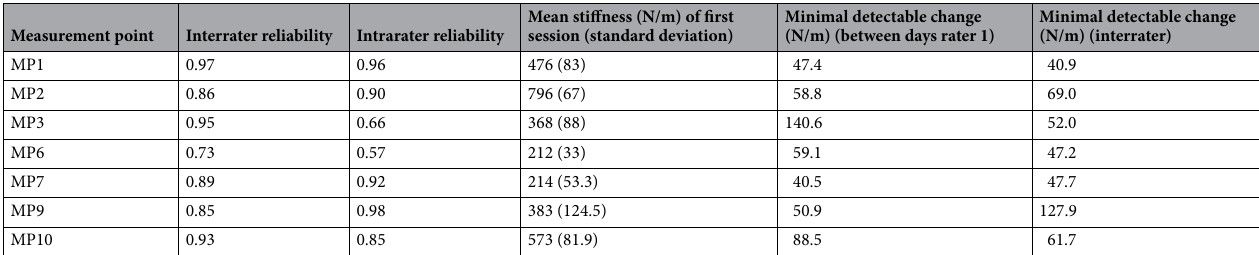
Table 1. MyotonPRO stiffness results for intrarater (between days) and interrater reliability, mean stiffness of first session and minimal detectable change (within and between raters). MP1 Plantar Fascia, MP2 Achilles